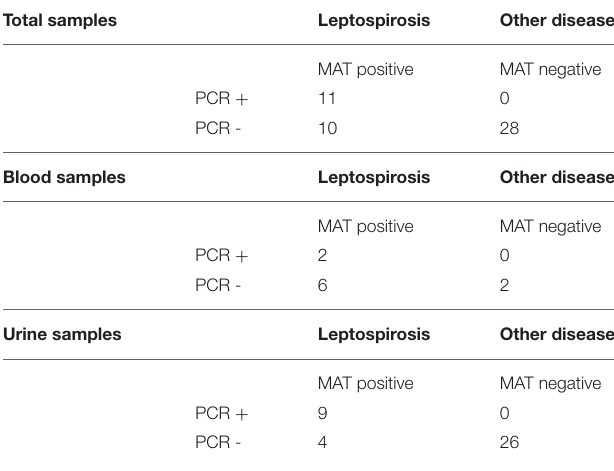
TABLE 1 | PCR assay results compared with microagglutination titer (MAT) results in total, from blood alone, and from urine alone in dogs of this